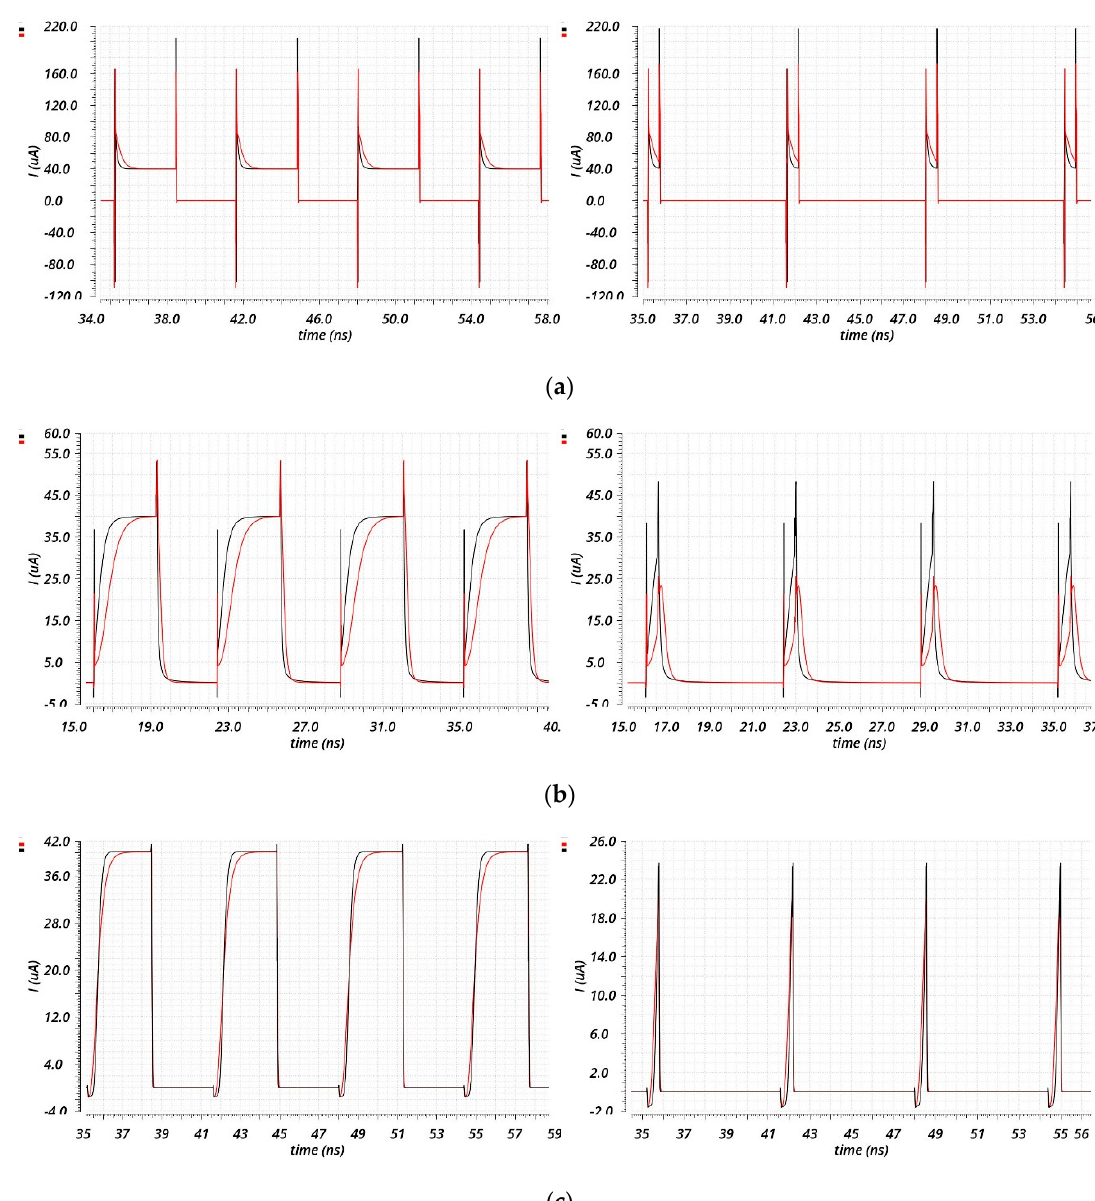
Figure 8. Transient behavior of the three CPs of Figure 7. The source current is represented in red, while the sink current is represented in black for two different values of ON time of the input signals (UP and DOWN): 3.2 ns on the left, which corresponds to a duty cycle of 50%, and 500 ps on the right, which corresponds to a duty cycle of 7.8125%. The Drain Switching CP results are represented in ( a ); the Source Switching CP results are represented in ( b ); the Gate Switching CP results are represented in ( c ).